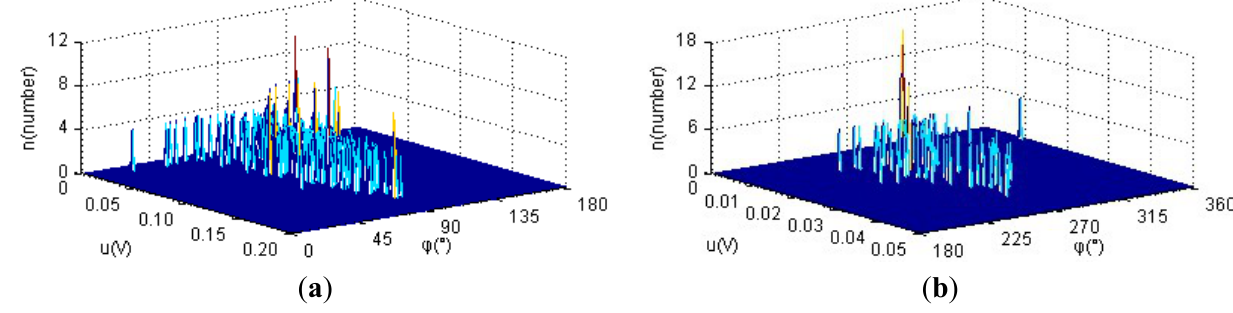
Figure 10. PD n-u- φ distribution: ( a ) PD optical pulses under positive half cycle; ( b ) PD optical pulses under negative half